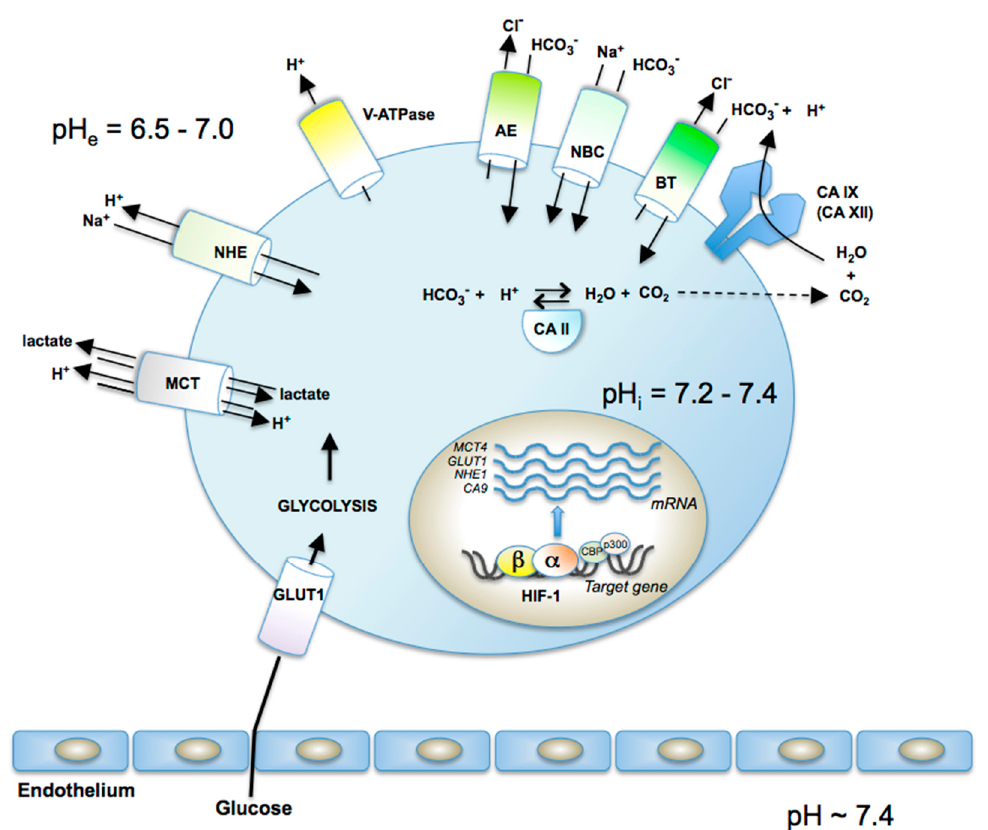
Figure 2. Proteins involved in pH regulation in tumors: GLUT1, the glucose transporter isoform 1; MCT, monocarboxylate transporter, which extrude lactic acid and other monocarboxylates formed by the glycolytic degradation of glucose; NHE, sodium-proton exchanger (Na + –H + antiporter); V-ATPase, plasma membrane proton pump; AE, anion exchanger (chloride-bicarbonate exchanger); NBC, sodium bicarbonate channels; BT, bicarbonate transporter; CA II (cytosolic) and CA IX/XII, which catalyze CO 2 hydration to bicarbonate and protons [4–15].